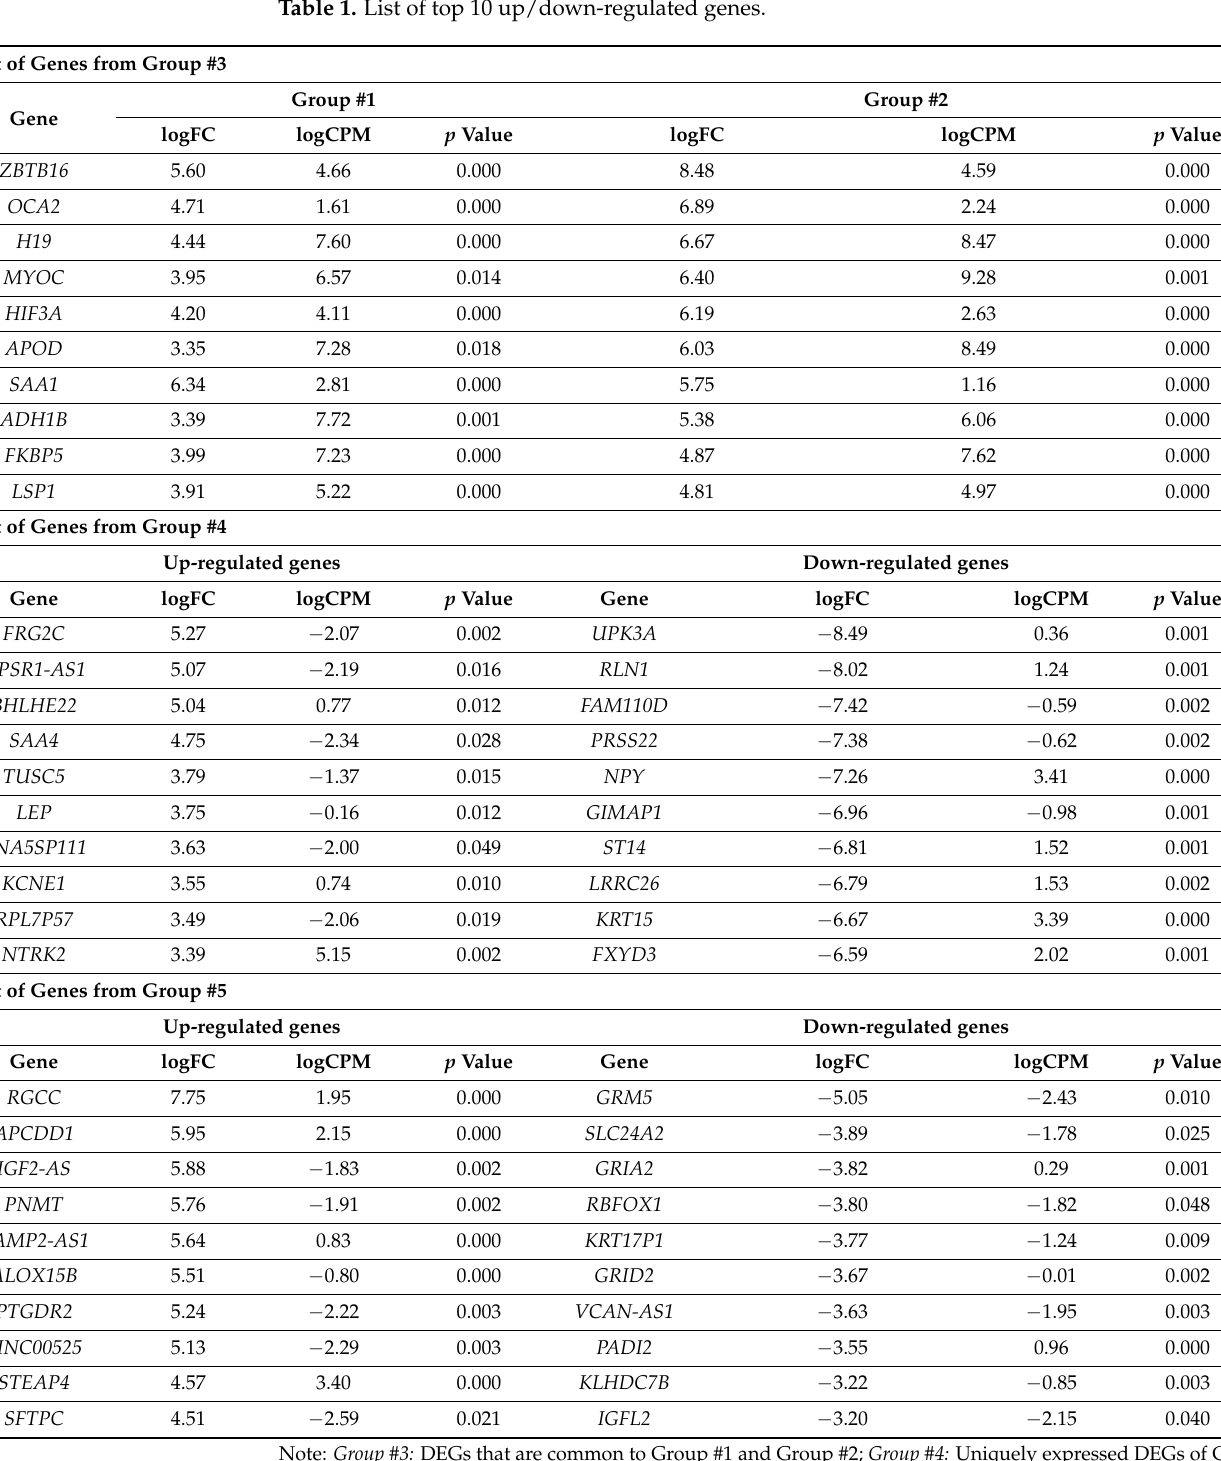
Table 1. List of top 10 up/down-regulated